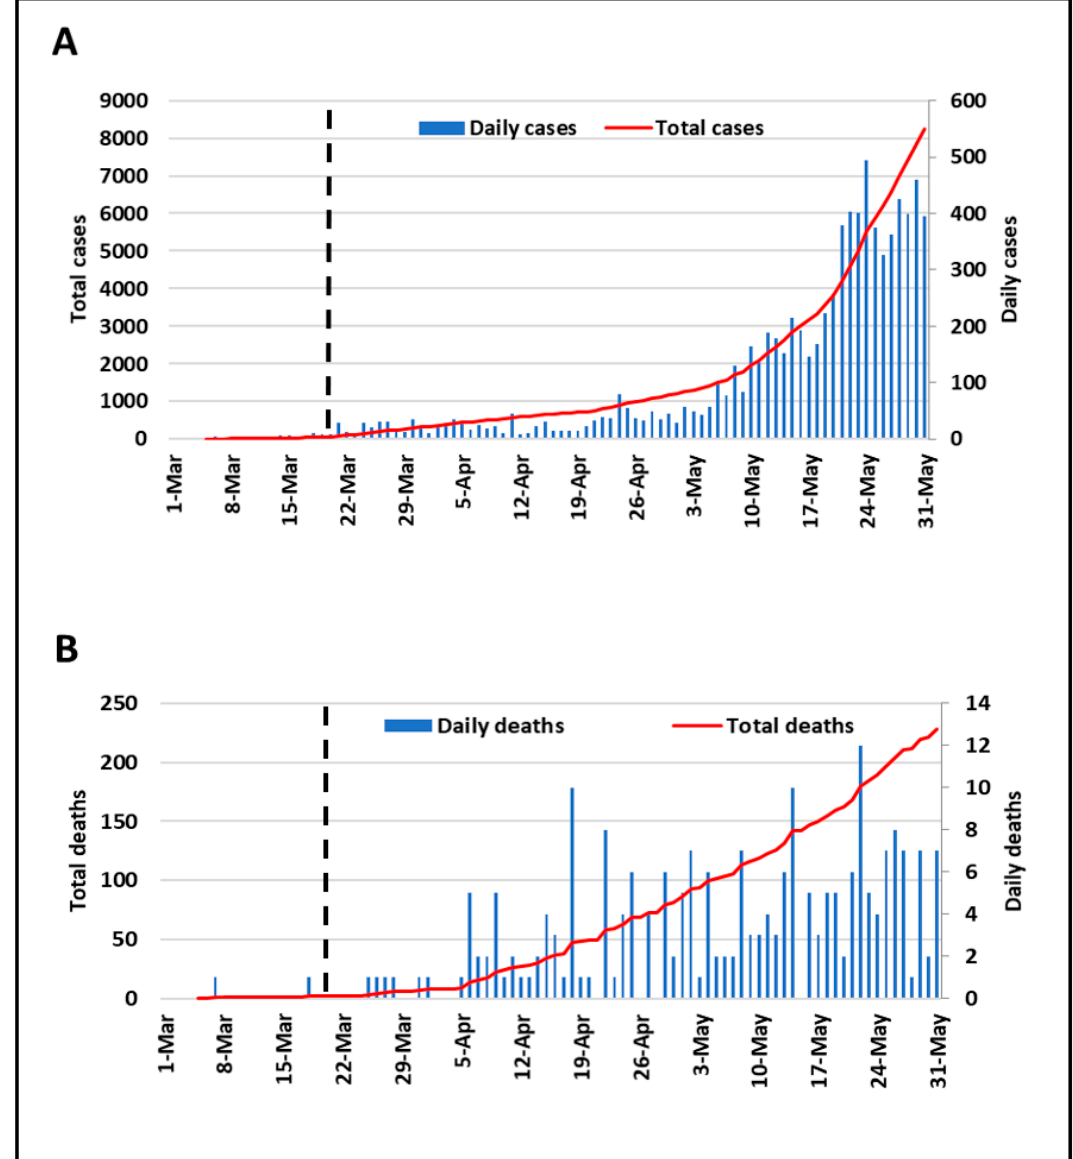
Figure 2. Daily (new) and total cases for infections ( A ) and deaths ( B ) due to COVID-19 in CABA, until the last week of May 2020. The black dotted line indicates the start of the pandemic lockdown